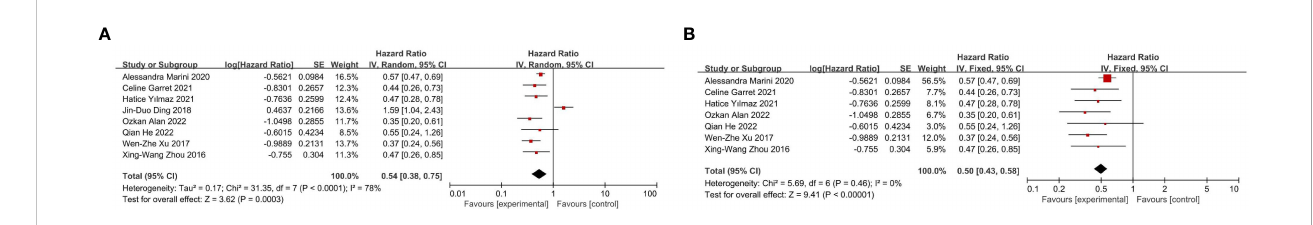
FIGURE 2 (A) Forest plot of correlation between PNI score and OS in univariate analysis data. (B) Adjusted forest map of correlation between PNI score and OS in univariate analysis